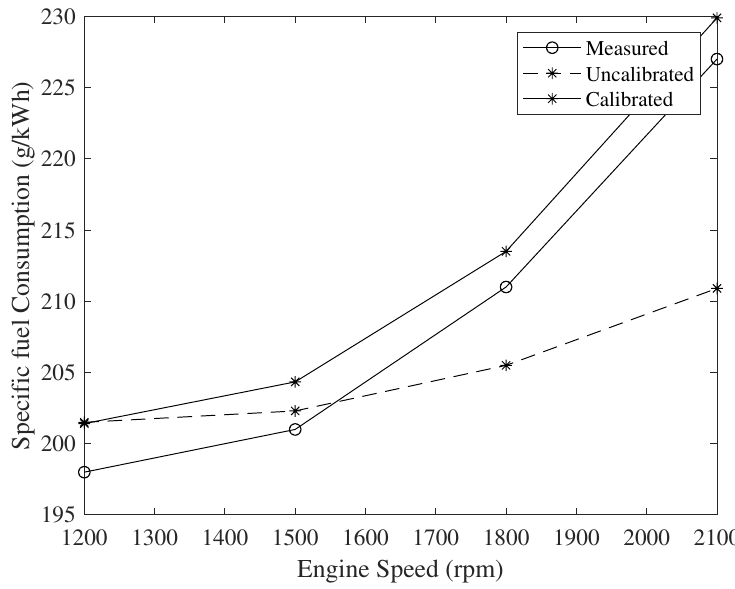
Figure 6. Calculated b ef compared to Scania DC 09 engine full-load b ef curve.